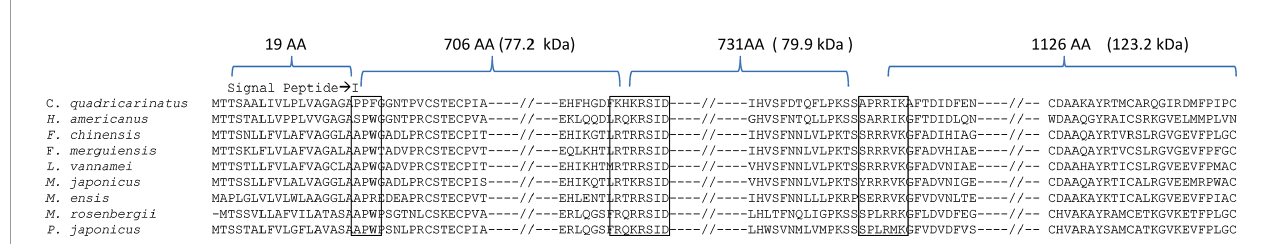
FIGURE 5 | Alignment of selected decapod vitellogenin sequences. The open boxes marked regions consisting of conserved amino acid sequence for peptide cleavage sites. The symbol “— // —” indicates omission of other regions for simpli fi cation of the alignment. With reference to L. vannamei , the LvVg precursor was predicted to produce subunits of 72.2, 79.9, and 123.2 kDa.